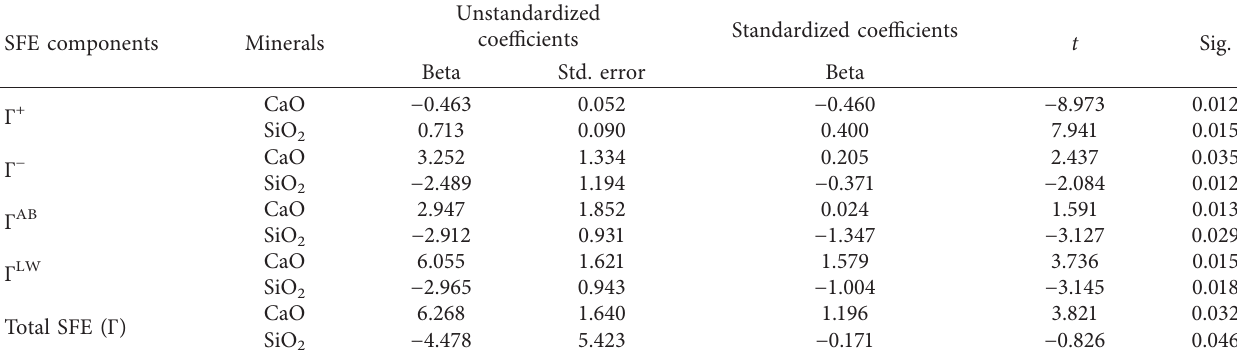
Table 11: Analysis of the effect of minerals on SFE after 1, 3, and 5 F-T